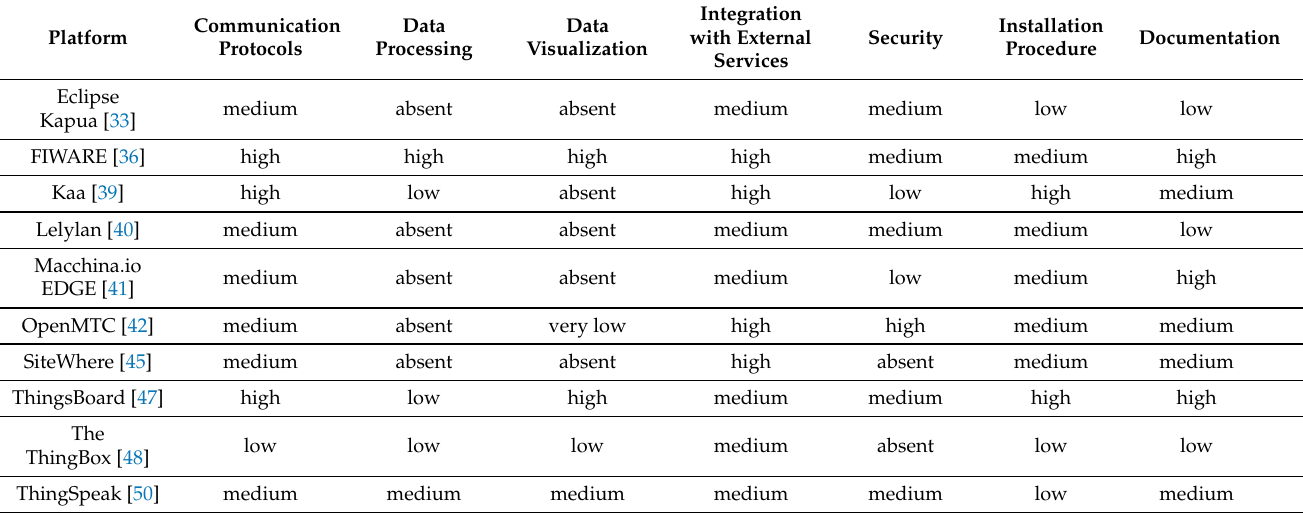
Table 3. Qualitative comparison between open source platforms analyzed in Section